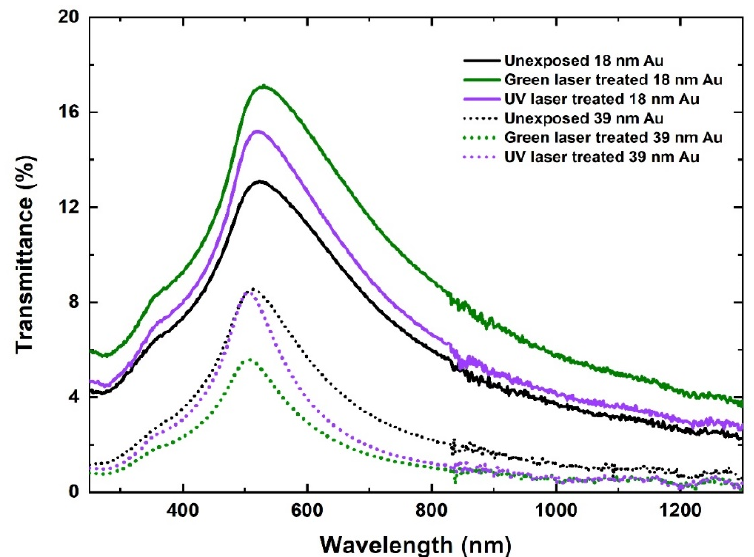
Figure 7. Effect of laser crystallization on optical properties of 18-nm and 39-nm thick Au films before and after green and UV laser scanning, respectively.